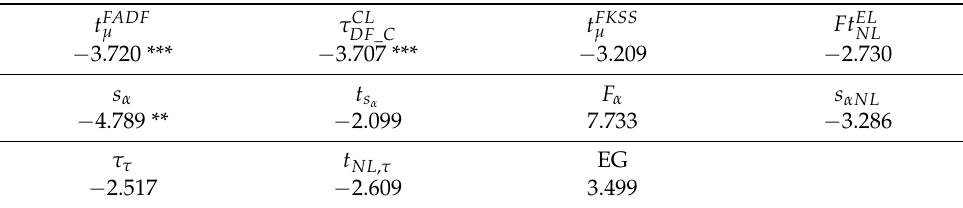
Table 7. Empirical application to the term structure data over 1990:1–2003:11.